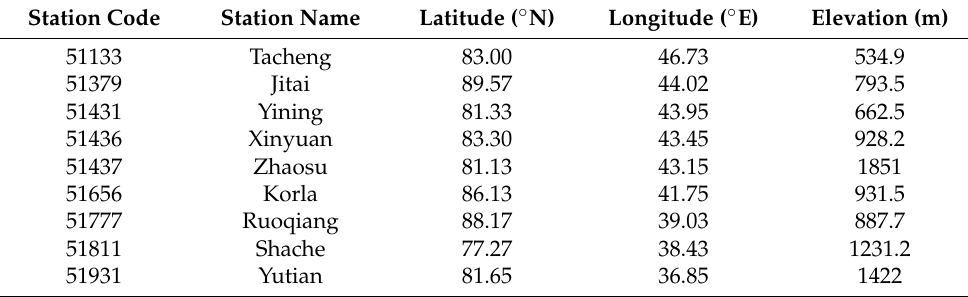
Table 8. Soil moisture site